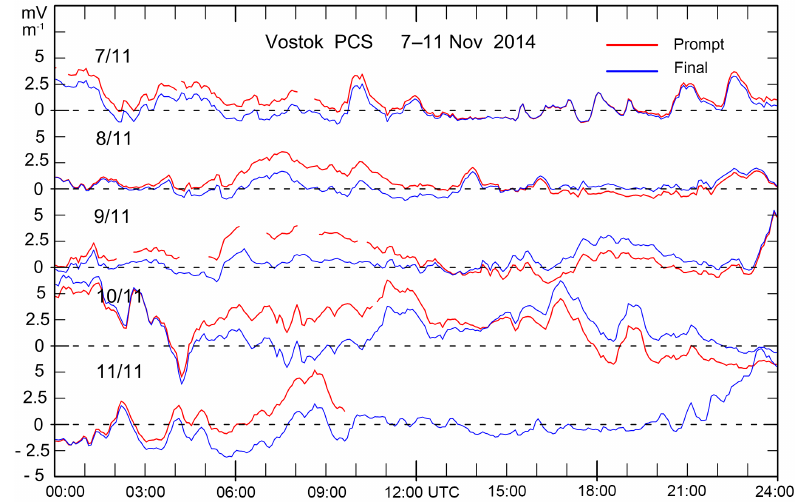
Figure 6. PCS indices for 7 to 11 November 2014 from downloads on 11 November 2014 (red line) and 25 October 2017 (blue line). The prompt values shown by the red curve terminate in the real-time PCS value at the time of download. The displayed values are 5min averages of the 1min